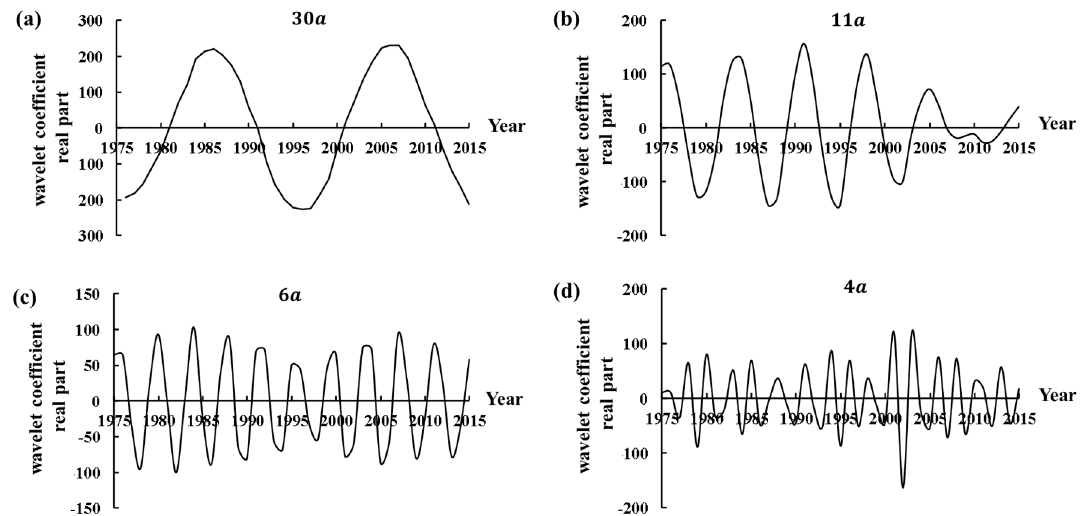
Figure 8. Real part variation process of annual runoff anomaly series wavelet coefficients. ( a ) Time scale of 30 a ; ( b ) Time scale of 11 a ; ( c ) Time scale of 6 a ; ( d ) Time scale of 4 a .